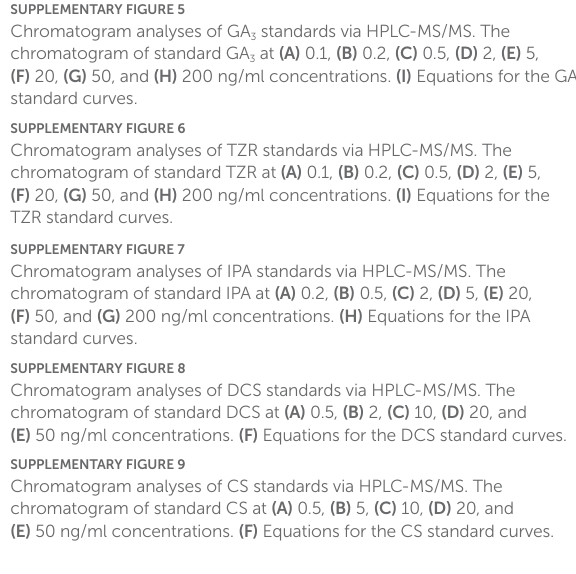
SUPPLEMENTARY FIGURE 1 Amino acid sequences alignment of PtHMGR protein and other known HMGR proteins. The high similarities between Populus species and the other species are exhibited. The name of species and also their accession numbers are presented. The HMG-CoA and NADPH binding domains are indicated in red rectangular. SUPPLEMENTARY FIGURE 2 Construction of a phylogenetic tree based on the HMGR sequences of various species. HMGR has been isolated from 35 species via blast on NCBI and aligned, followed by a phylogenetic tree. Results reveal a highly conserved HMGR through all the species. The gray rectangular shows similar HMGR1 via Populus species located on one root, followed by a red dashed rectangle to show the organisms and accession numbers. The names of organisms and corresponding accession numbers are presented. SUPPLEMENTARY FIGURE 3 Confirming of transformation of PtHMGR - OEs . (A) Schematic of constructed cassette transformed into the PtHMGR transgenic poplars. (B) PCR identification of PtHMGR in PtHMGR - OEs and NT poplars. Lane M: 15K molecular mass marker (TransGen, China); lane 1: genome DNA from NT as negative control; lanes 2–9: genome DNA from PtHMGR-OE lines. (C) qRT-PCR identifies the transcript levels of PtHMGR in PtHMGR - OEs and NT poplars. Three independent experiments were performed; Stars reveal significant differences, * p < 0.05, ** p < 0.01, *** p < 0.001. SUPPLEMENTARY FIGURE 4 MEP and MVA-related genes analyses in PtHMGR - and PtDXR- OEs poplars. (A) MVA-related genes AACT , HMGS , HMGR , MVK , MVD, and FPS are affected by the overexpression of PtHMGR . (B) MVA-related genes AACT , HMGS , HMGR , MVK , MVD, and FPS are affected by the overexpression of PtDXR . (C) MEP-related genes DXS , MCT , CMK , HDS , HDR , IDI, GPS, GPPS, and DXR are affected by the overexpression of PtHMGR . (D) MEP-related genes DXS , DXR , MCT , CMK , HDS , HDR , IDI , GPS, and GPPS are affected by the overexpression of PtHMGR . PtActin was used as an internal reference in all repeats; * p < 0.05, ** p < 0.01, *** p < 0.001, **** p < 0.0001; Three independent replications were performed in this experiment. SUPPLEMENTARY FIGURE 5 Chromatogram analyses of GA 3 standards via HPLC-MS/MS. The chromatogram of standard GA 3 at (A) 0.1, (B) 0.2, (C) 0.5, (D) 2, (E) 5, (F) 20, (G) 50, and (H) 200 ng/ml concentrations. (I) Equations for the GA 3 standard curves. SUPPLEMENTARY FIGURE 6 Chromatogram analyses of TZR standards via HPLC-MS/MS. The chromatogram of standard TZR at (A) 0.1, (B) 0.2, (C) 0.5, (D) 2, (E) 5, (F) 20, (G) 50, and (H) 200 ng/ml concentrations. (I) Equations for the TZR standard curves. SUPPLEMENTARY FIGURE 7 Chromatogram analyses of IPA standards via HPLC-MS/MS. The chromatogram of standard IPA at (A) 0.2, (B) 0.5, (C) 2, (D) 5, (E) 20, (F) 50, and (G) 200 ng/ml concentrations. (H) Equations for the IPA standard curves. SUPPLEMENTARY FIGURE 8 Chromatogram analyses of DCS standards via HPLC-MS/MS. The chromatogram of standard DCS at (A) 0.5, (B) 2, (C) 10, (D) 20, and (E) 50 ng/ml concentrations. (F) Equations for the DCS standard curves. SUPPLEMENTARY FIGURE 9 Chromatogram analyses of CS standards via HPLC-MS/MS. The chromatogram of standard CS at (A) 0.5, (B) 5, (C) 10, (D) 20, and (E) 50 ng/ml concentrations. (F) Equations for the CS standard